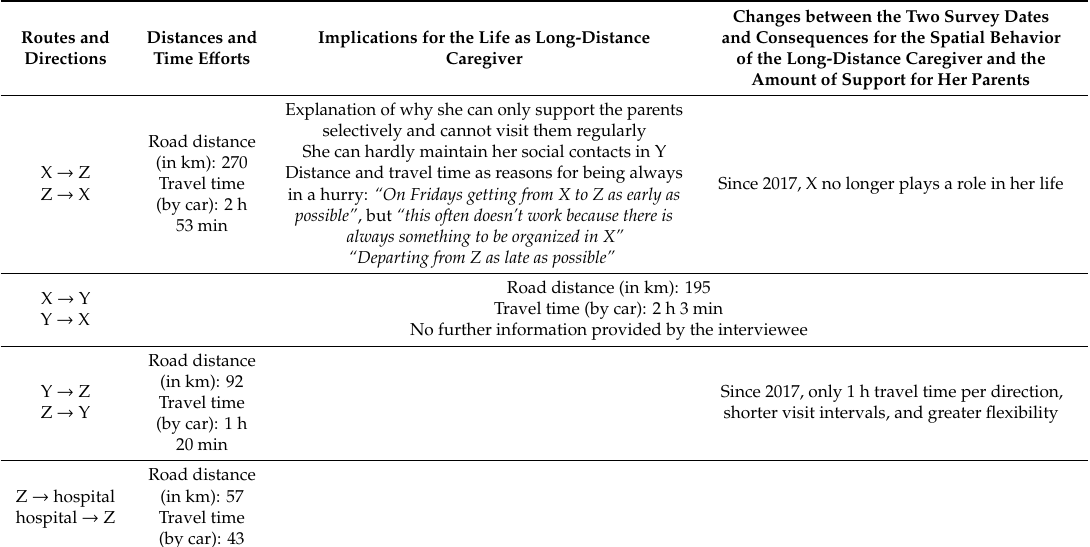
Table A3. Always on the move: Functional relationships between the relevant places; distances, time e ff orts, and emotions in the context of overcoming distances from the perspective of the long-distance